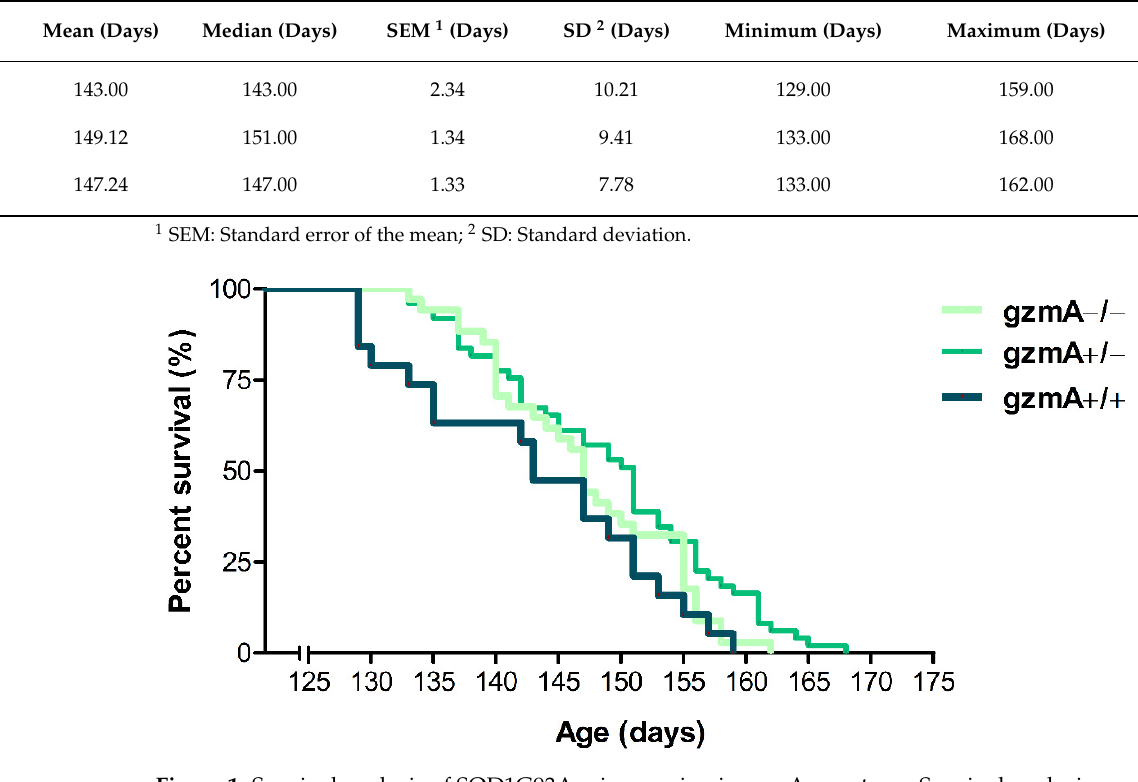
Figure 1. Survival analysis of SOD1G93A mice varying in gzmA genotype. Survival analysis was performed with mice showing the three gzmA genotypes (n = 34 gzmA − / − , n = 49 gzmA+/ − and n = 19 gzmA+/+). Survival curve showing statistically significant differences in the lifespan between gzmA+/ − and gzmA+/+ mice ( p = 0.022).